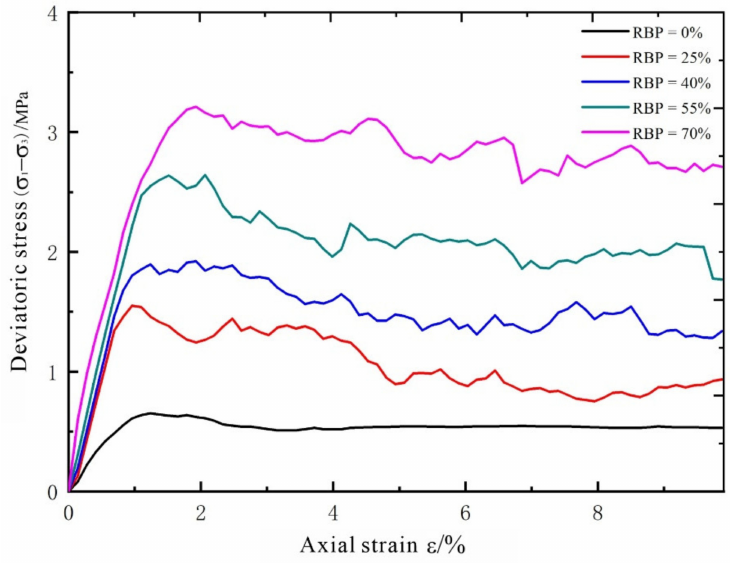
Figure 6. Relationship between stress and strain of